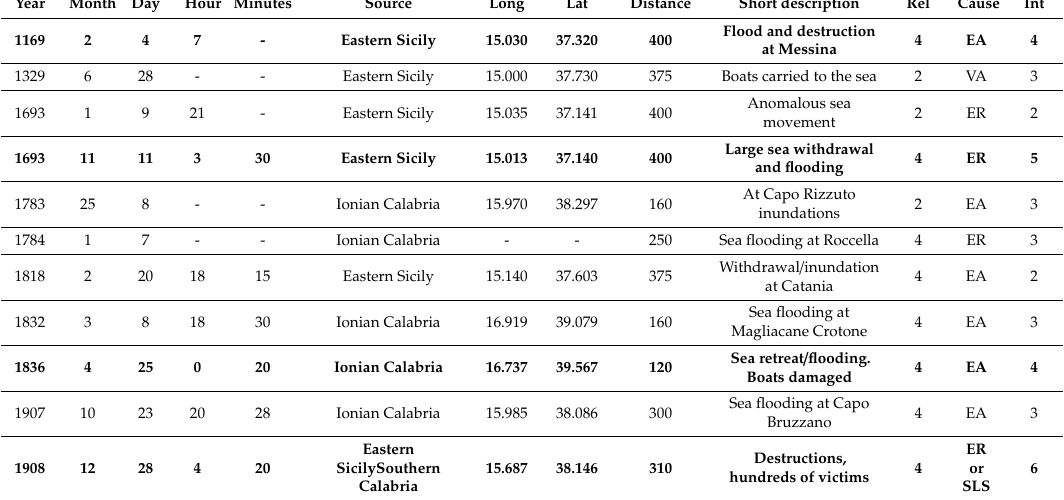
Table 3. List of tsunamis which occurred in the Ionian Sea (Italian area) during the last ten centuries from [2]. Distance is measured in km in a direct line from the epicenter to the Ionian coast of Southern Apulia. Reliability ranges from 0 (“very improbable tsunami”) to 4 (“definite tsunami”). Associated cause: ER (submarine earthquake), EA (earthquake in land), VA (volcano-related), SLS (submarine landslide). Intensity is according to the Sieberg–Ambraseys scale [31]. In particular, intensity 3 represents the threshold for which tsunamis are capable of producing some damage to boats and light coastal structures, while strong damage can be observed starting from intensity 4